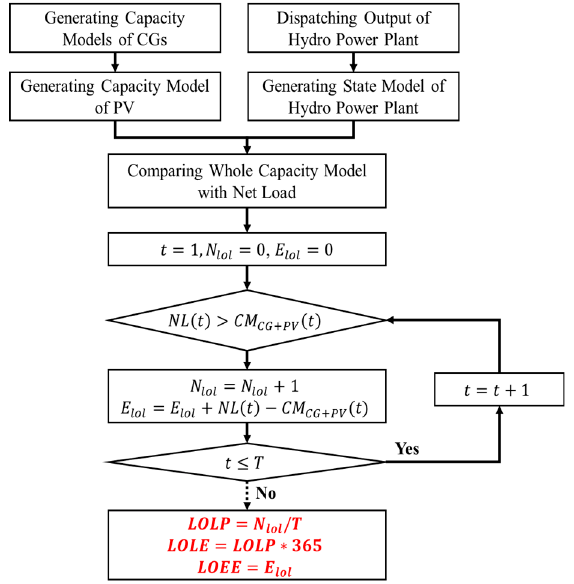
Figure 6. Flowchart of Reliability Evaluation at the First Stage.